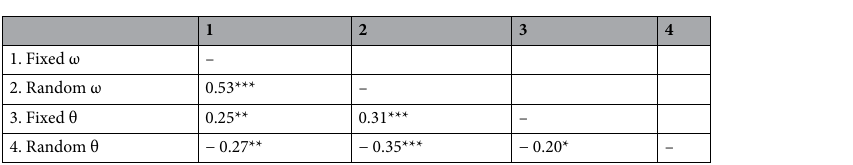
Table 1. Correlation matrix between navigation strategy (ω) and exploration–exploitation (θ) in the Fixed and Random phases. *p < 0.05, **p < 0.01, ***p <